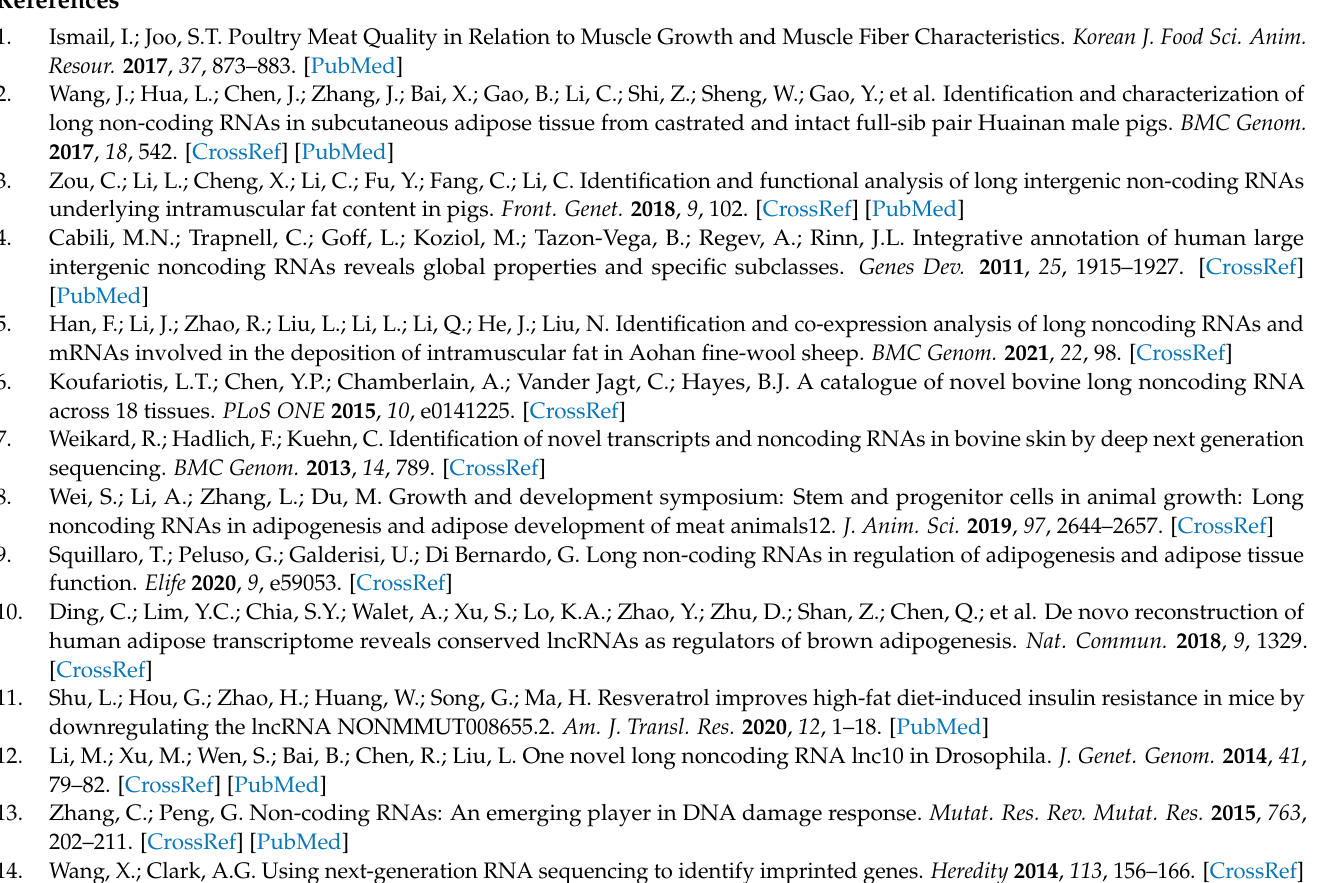
lncRNA statistics, Table S3: Differential lncRNA target gene statistics, Table S4: Differential mRNA GO analysis, Table S5: KEGG analysis of differential mRNA GO analysis, Table S6: GO analysis of target genes, Table S7: KEGG analysis of target genes, Table S8: Analysis results of